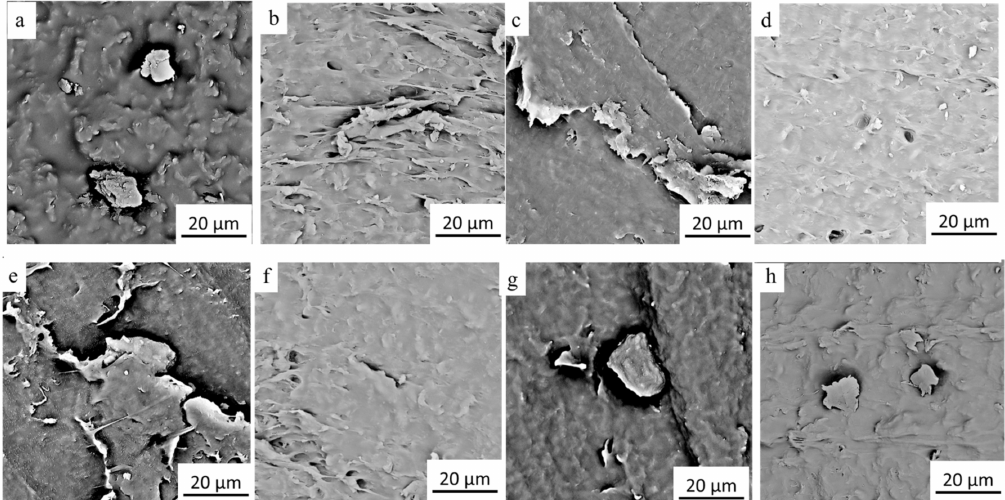
Figure 5. SEM images of top section (above) and cross-section (below) morphologies of the G-TPU films prepared from TPU with melting points of 100 ◦ C ( a , b ), 120 ◦ C ( c , d ), 140 ◦ C ( e , f ), 163 ◦ C ( g , h ), respectively, and the graphene mass content of 4